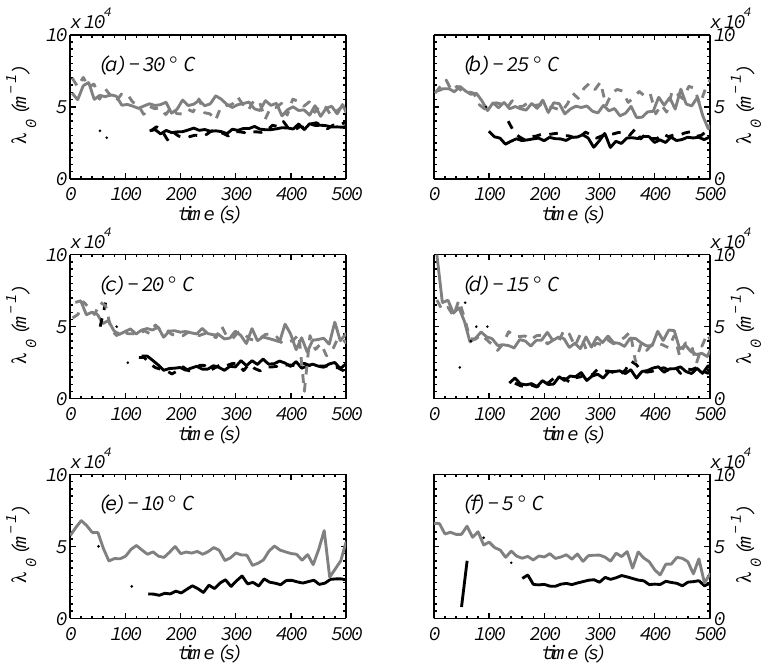
Fig. 10. Shows the slope of the distribution measured with the CPI for the different experiments. Solid grey lines are measurements at the middle of the chamber; solid black lines are measurements at the base of the chamber. Dashed lines are repeat experiments, which show some statistical variability, but in general good agreement. Panels are as in Fig. 8, but the slope is plotted instead of the concentration.